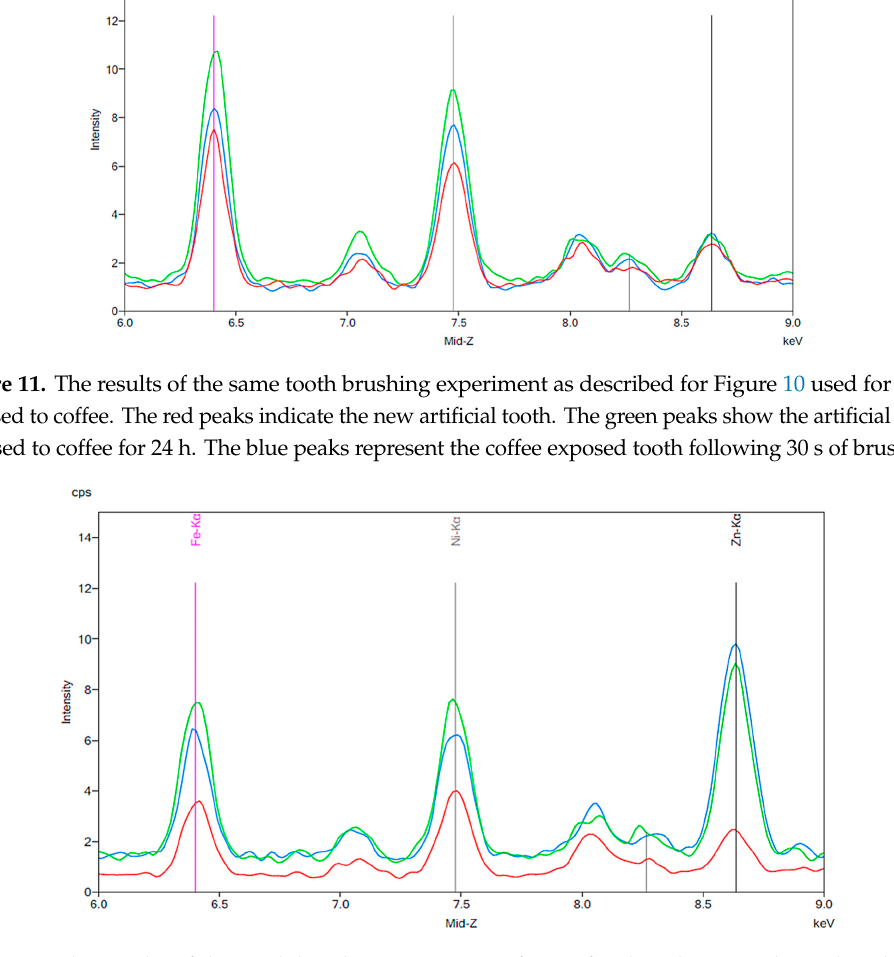
Figure 13. Baseline spectrum for a sample of chlorhexidine. The parameters are the same as those used for the other baseline spectra described in this paper.